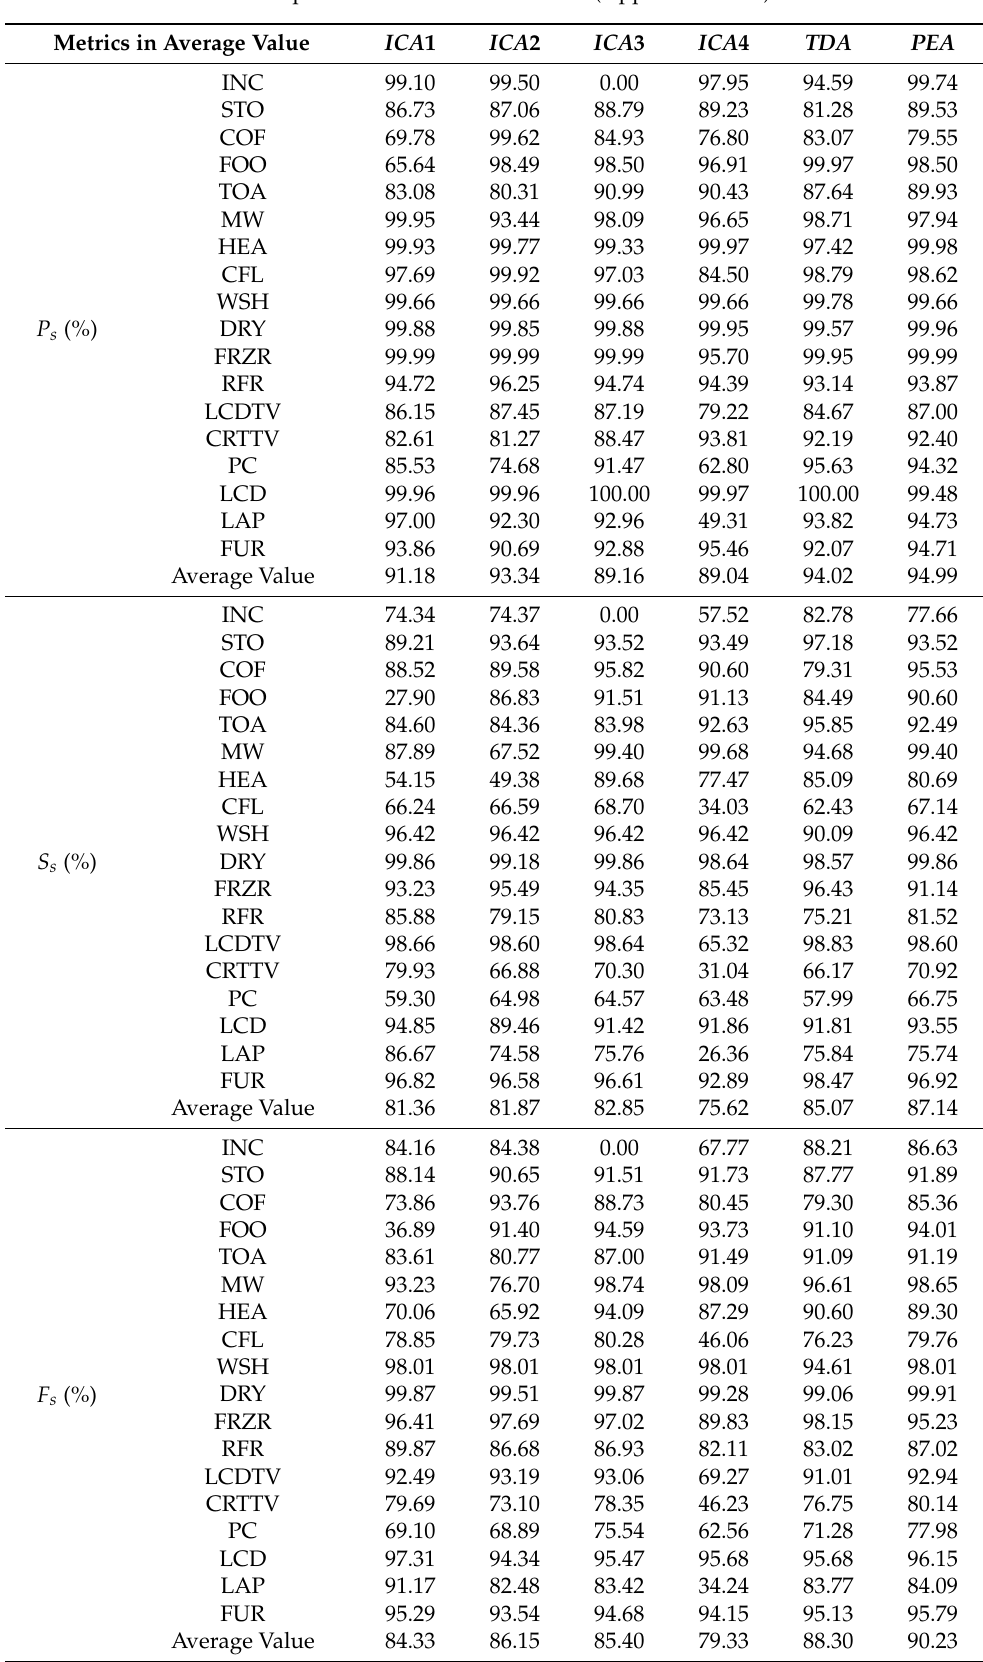
Table 4. Detailed results comparison of LVNS-based NILM (Appliance